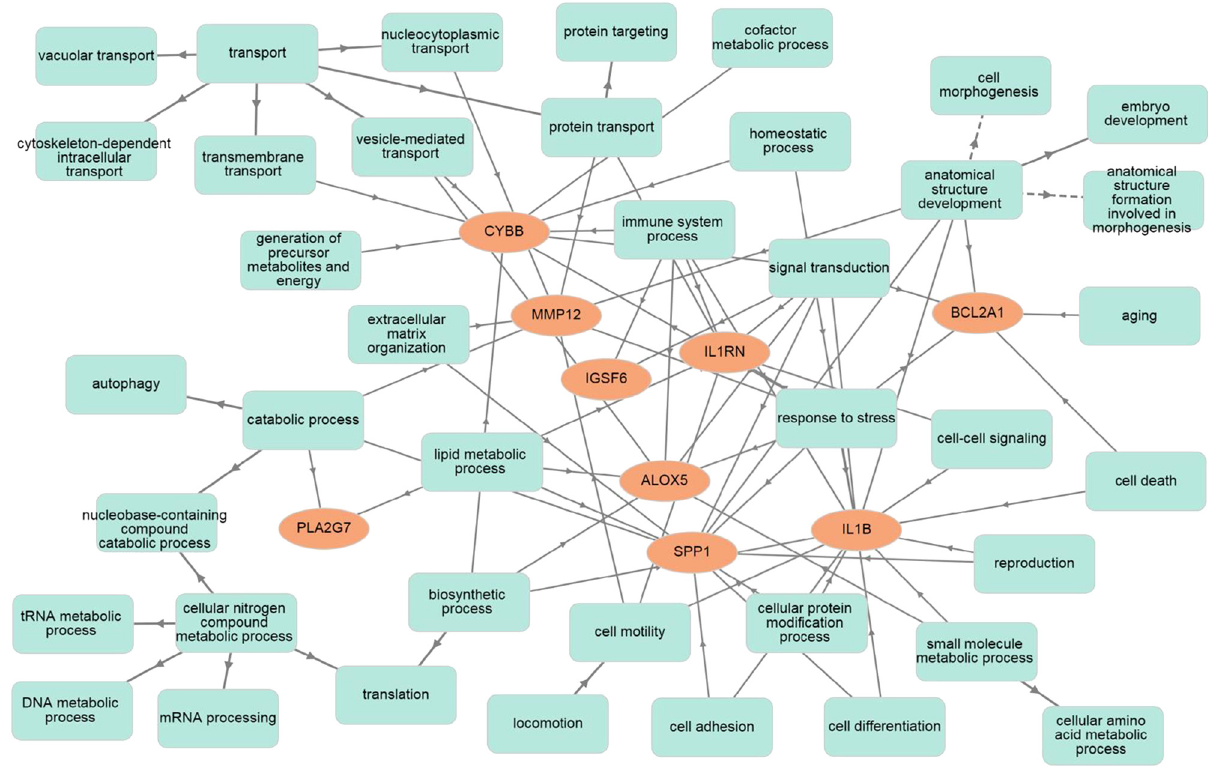
Figure 15: Schematic showing GO term annotation on the biological processes of the common upregulated di ff erentially expressed hub genes from the GSE5058, GSE11784, GSE11906, and GSE100927